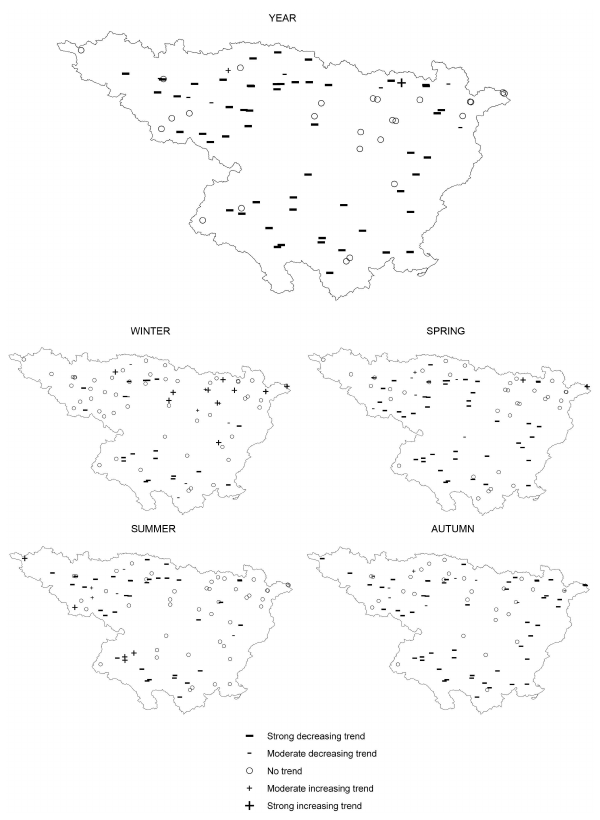
Fig. 6. Temporal evolution of runoff coefficient (water yield).